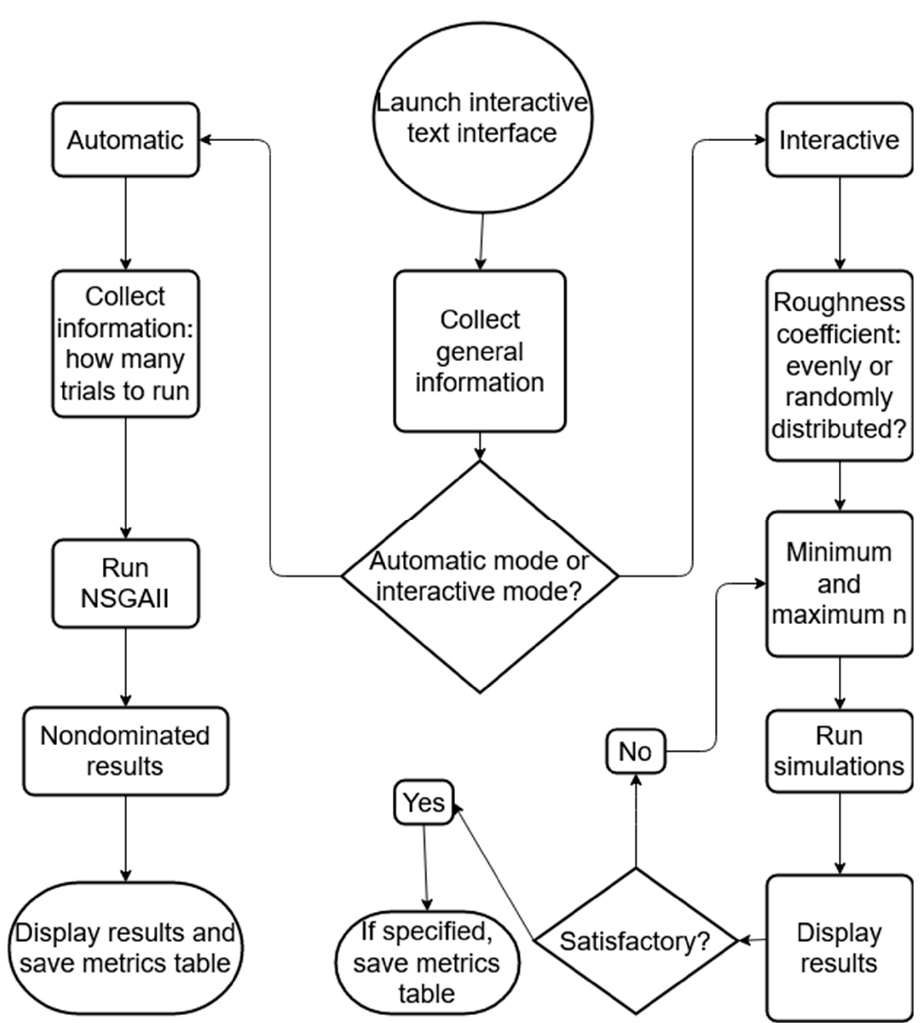
Figure 2. Process diagram for Raspy-Cal. The interface collects general information such as the project file, number of Manning’s n coefficients to test, whether to plot, and empirical data and either runs in interactive or automatic mode. Results are a table of metrics with nondominated results and, if specified, rating curves.